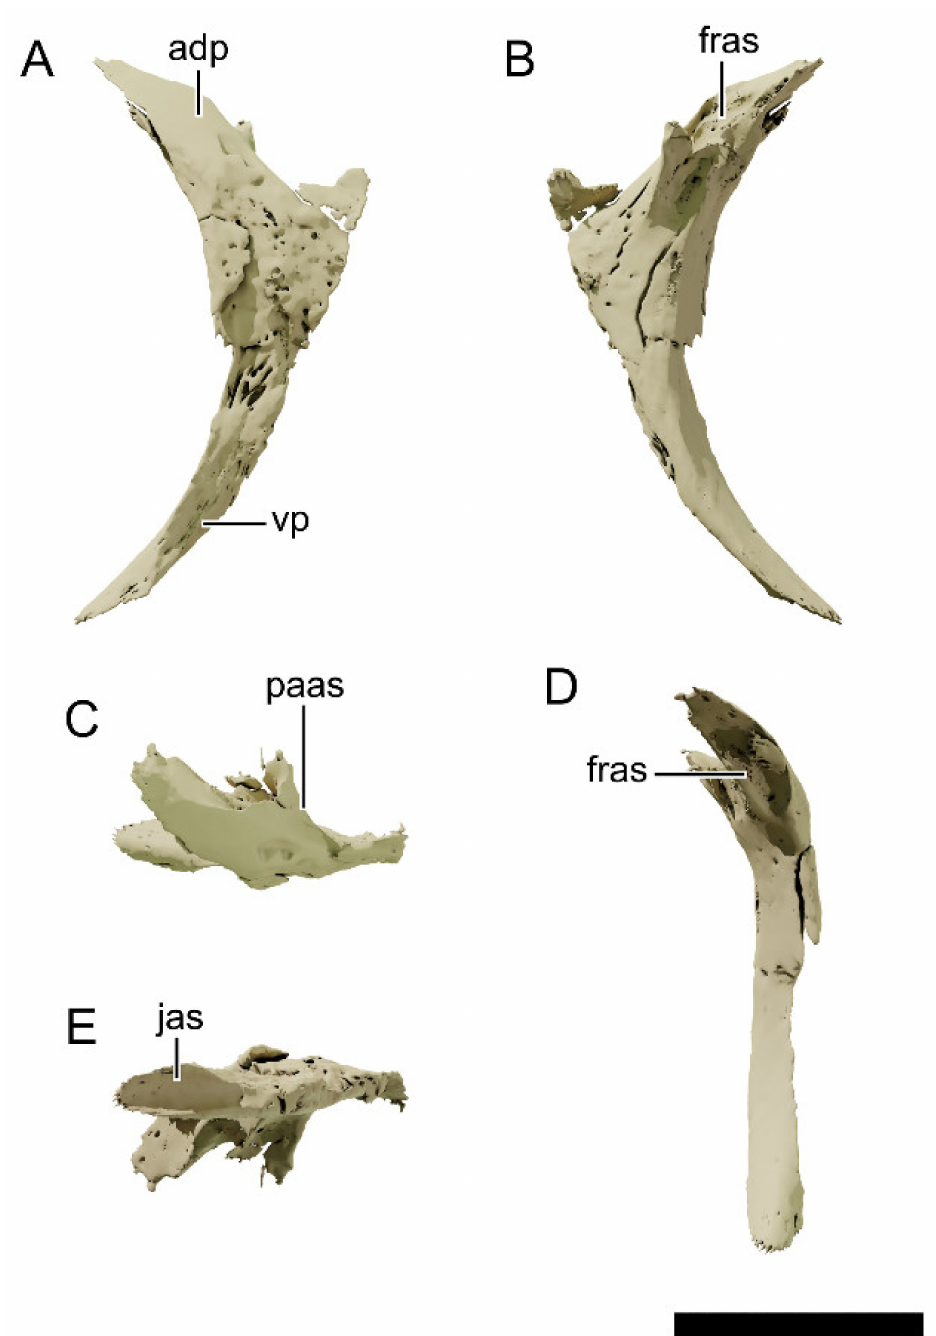
Figure 15. Digital reconstruction of the left postorbital of NHMD 164758. ( A ) Lateral view. ( B ) Medial view. ( C ) Dorsal view. ( D ) Ventral view. ( E ) Anterior view. Abbreviations: adp, anterodorsal process; fras, articular surface for the frontal; jas, articular surface for the jugal; paas, articular surface for the parietal; vp, ventral process. Scale bar = 20 mm. The posterior process of the postorbital is only preserved in NHMD 164741. This process is lateromedially slender and dorsally convex. It articulates dorsally and medially to the anterior process of the squamosal, with the dorsolateral surface partially covered by the squamosal. The posterior process of the postorbital forms an angle to the anterior process of 149 ◦ in NHMD 164741 and 134 ◦ in NHMD 164758. In Plateosaurus these angles vary between 160 ◦ in AMNH FARB 6810 and MSF 11.4, and 110 ◦ in MSF 12.3. This latter is thought to be closer to the original condition, as the former were mediolaterally